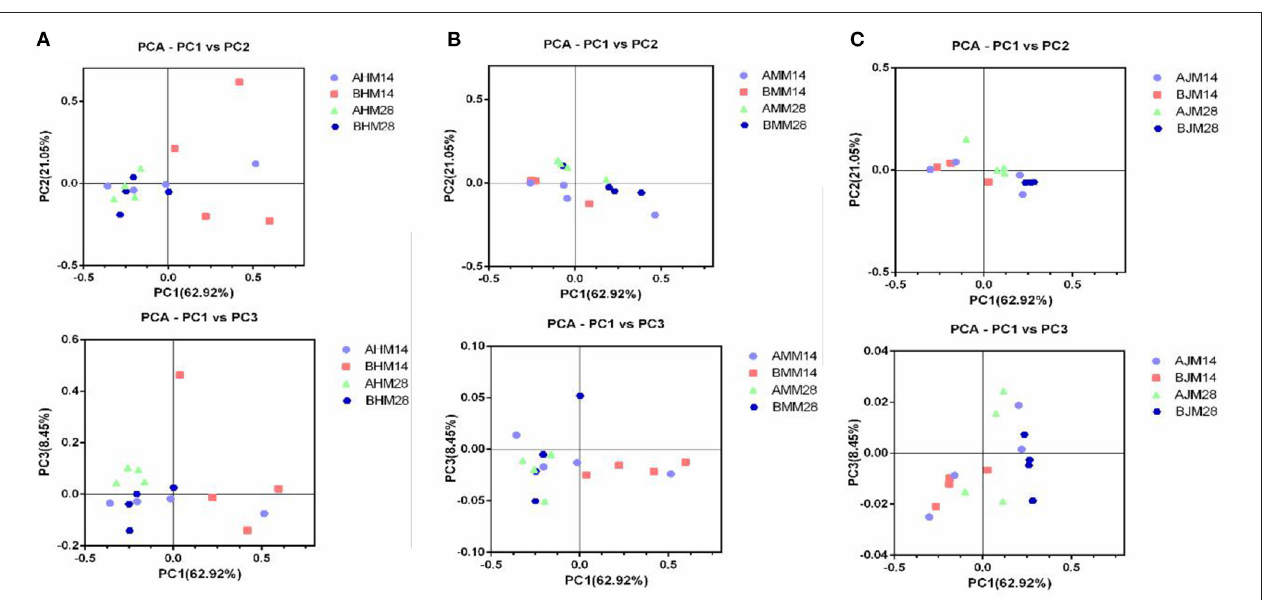
period increased the ADG of pre-weaning piglets (11).